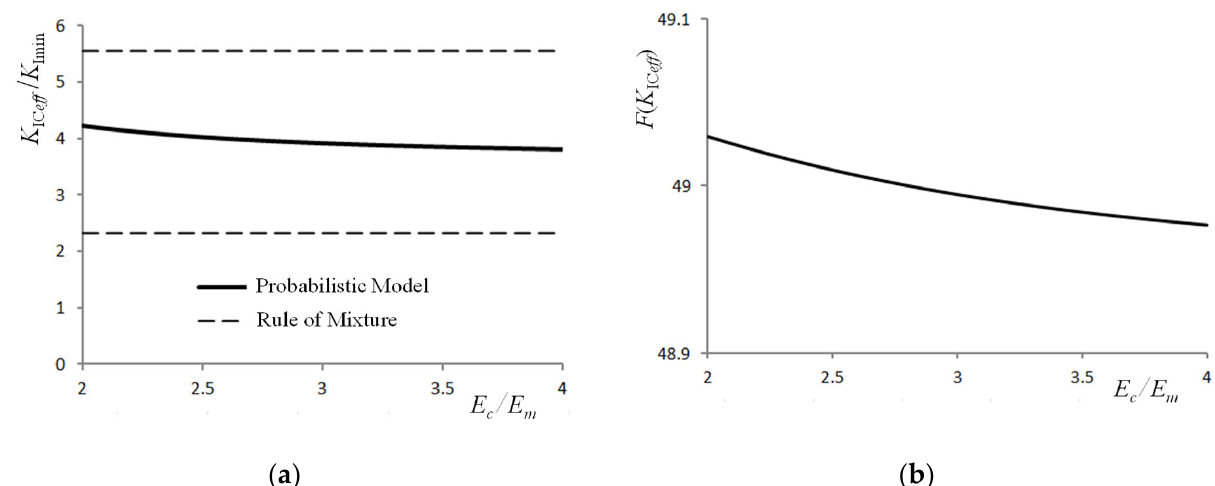
Figure 8. E ff ect of the change in the Young’s modulus of the composite on the fracture toughness ( a ) and the cumulative probability of fracture ( b ), K Ici / K Icm = 1/8, K Imin = K Ici = 5 (MPa·m 0.5 ), σ yc / σ ym = 2, E m = 70 (GPa), σ ym = 150 (MPa), V i = 0.35.